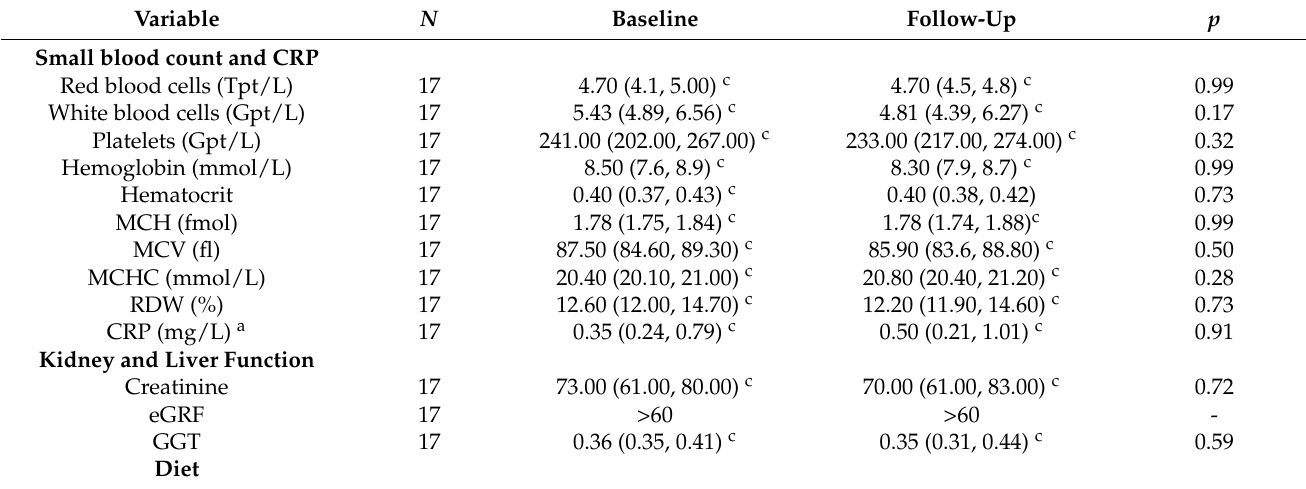
Figure 1. Study participant flowchart. Table 1. Descriptive characteristics of participants at each assessment.